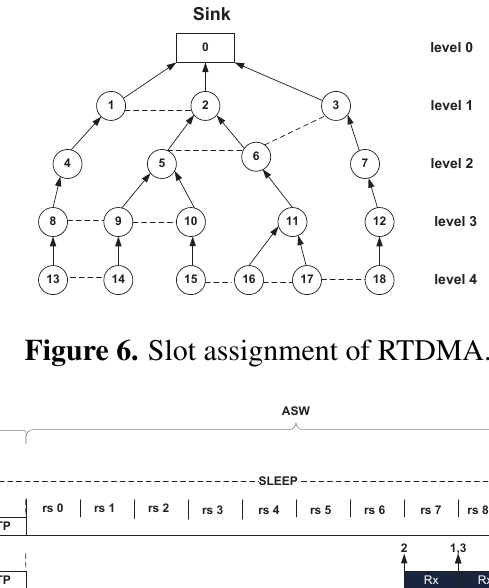
Figure 5. Routing tree for 19 nodes where node 0 is the sink. The arrow indicates the parent-child relationship and the dotted line indicates the communication link with non-parent-child neighbor.